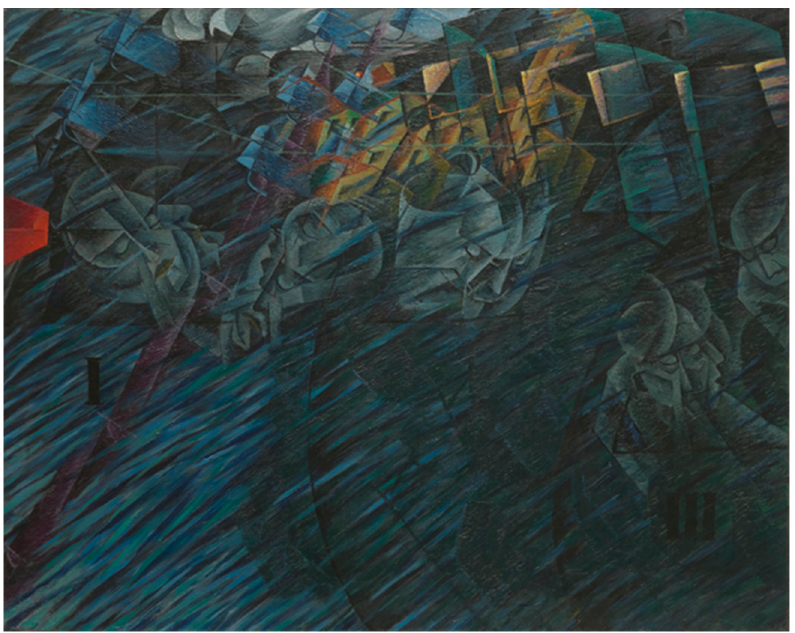
Figure 8. Advertisement for the Albee Theater, New York Journal-American, 28 March 1956, p. 24.